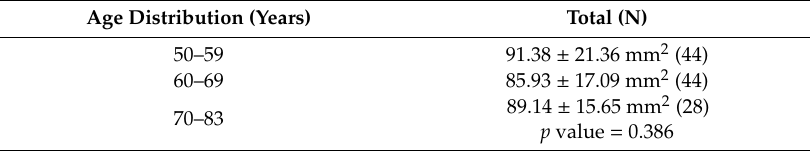
Table 3. The age distribution of patients with the mean IAPCSA of the CLSS group.